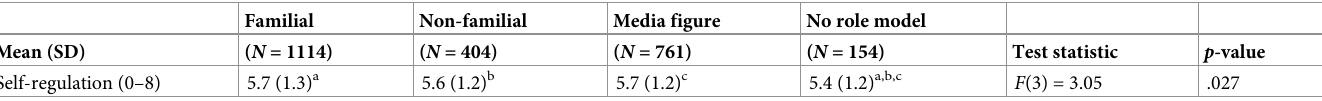
Table 4. Level of self-regulation according to role model presence and